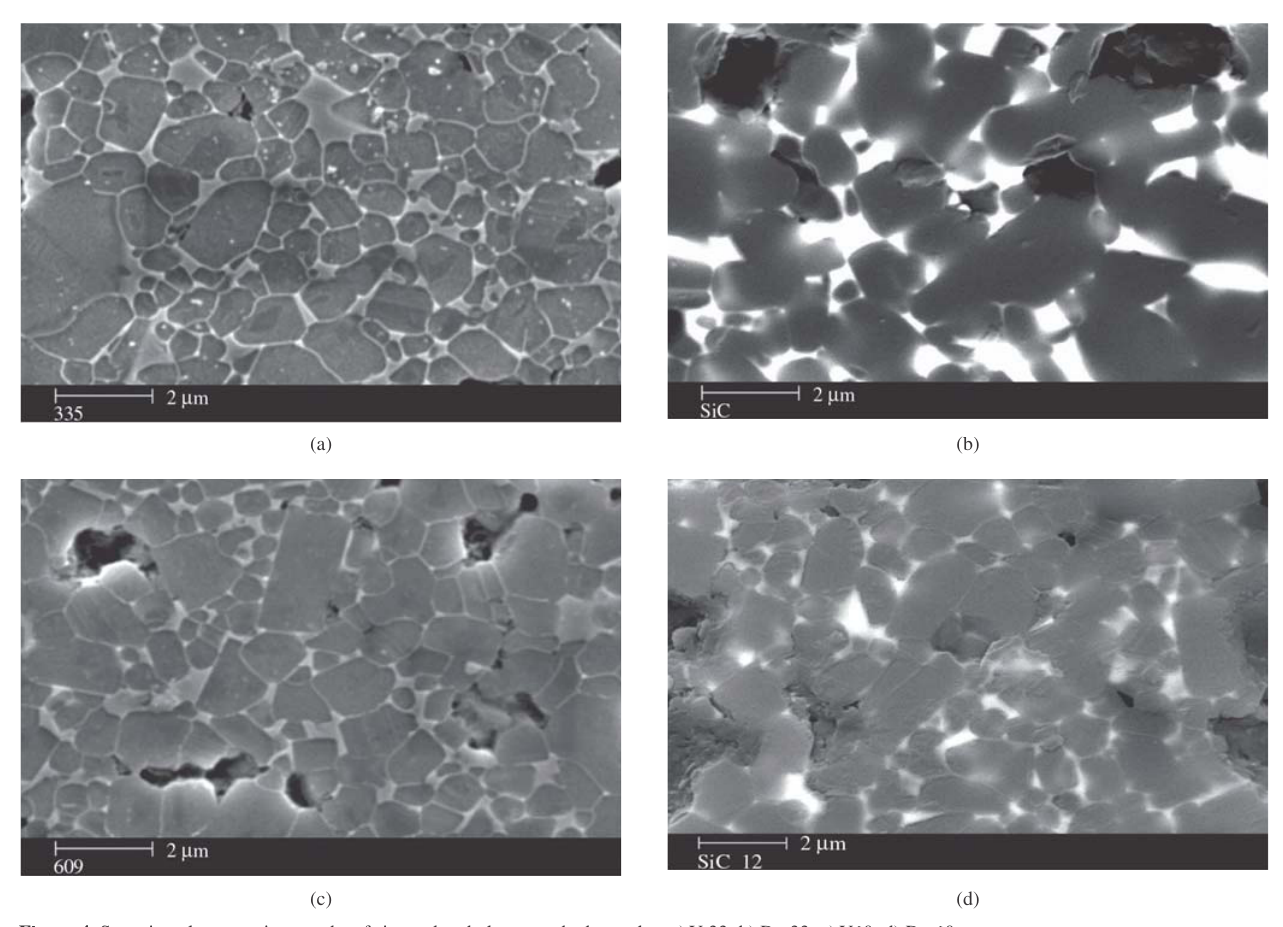
Figure 4. Scanning electron micrographs of sintered and plasma etched samples: a) Y 33; b) Dy 33; c) Y60; d) Dy